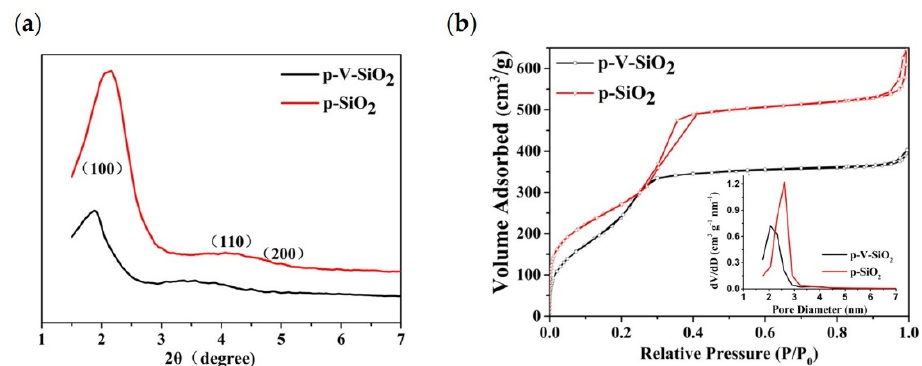
Figure 2. ( a ) Small-angle XRD patterns of p-V-SiO 2 and p-SiO 2 . ( b ) Nitrogen adsorption isotherms of p-V-SiO 2 and p-SiO 2 . The inset demonstrates the pore diameter distribution of p-V-SiO 2 and p-SiO 2 . Table 1. The data of specific surface areas, pore volumes, and pore sizes of p-V-SiO 2 and p-SiO 2 . Sample BET Surface Area (m 2 /g) Pore Volume (cm 3 /g) Pore Diameter (nm) p-SiO 2